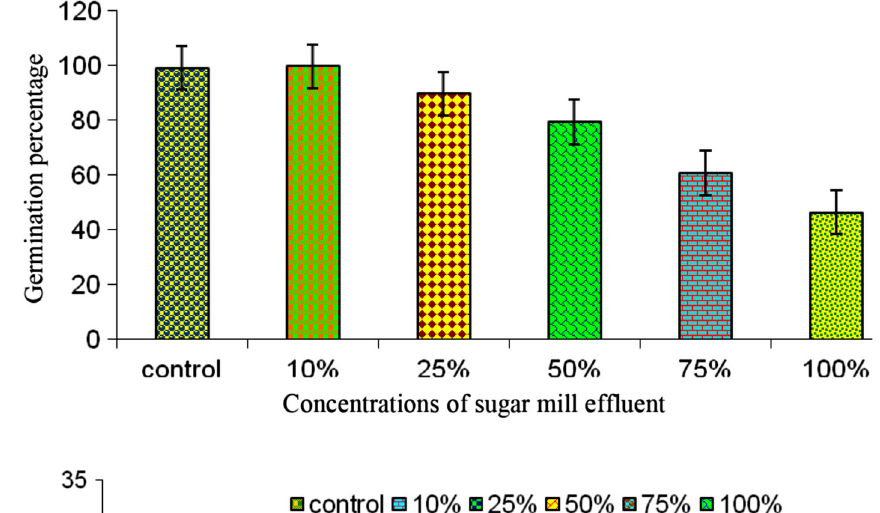
Fig. 2 Shoot length and root length of Tagetes erecta L. grown under different concentrations of sugar mill effluent